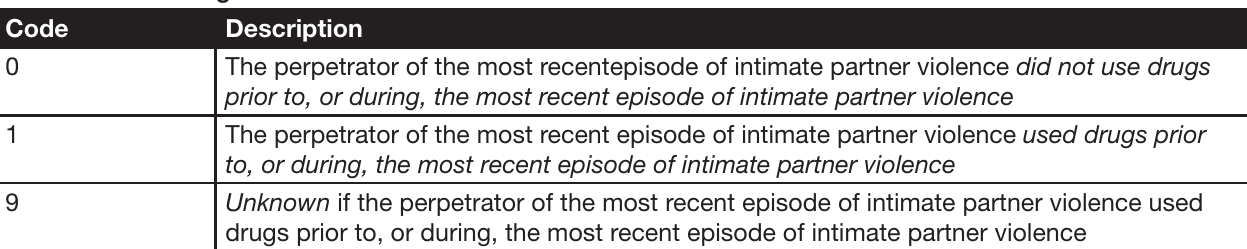
INTIMATE PARTNER VIOLENCE: UNIFORM DEFINITIONS AND RECOMMENDED DATA